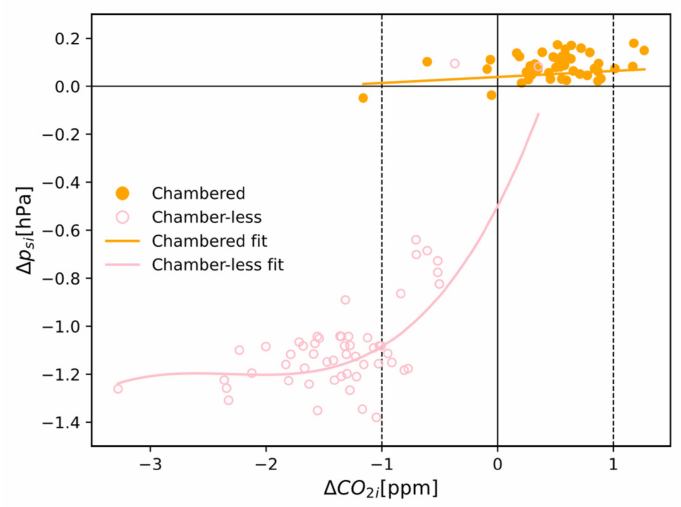
Figure 6. Distribution of mean CO 2 concentration anomalous biases ( ∆ CO 2 air pressure anomalous biases ( ∆ p s less